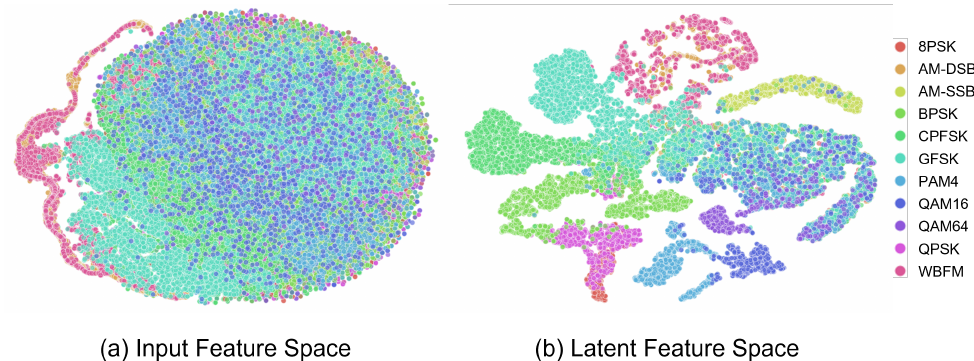
Figure 5. t-SNE of the input space vs. the latent feature